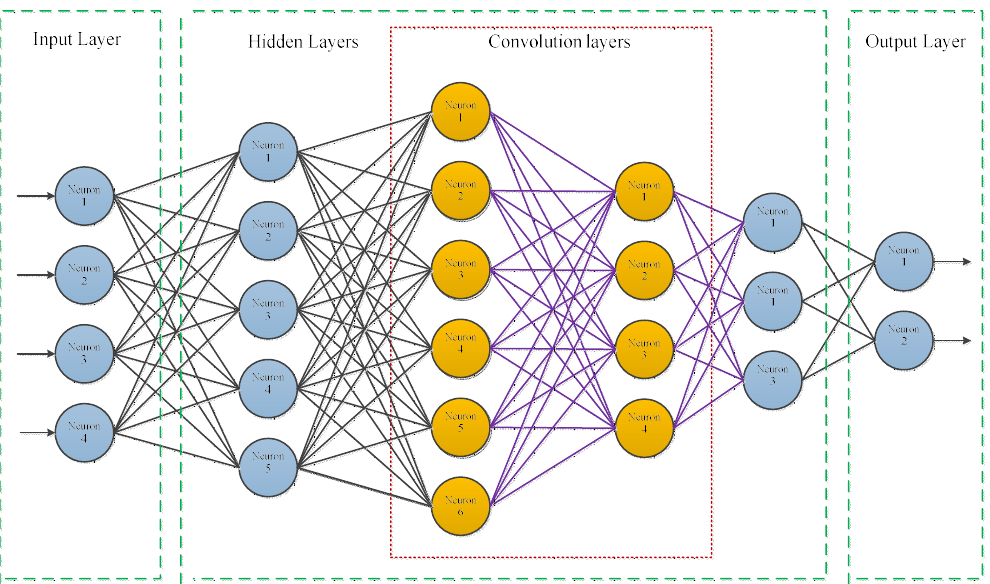
Figure 6. Details of the convolution neural network architectures network with convolution layers.